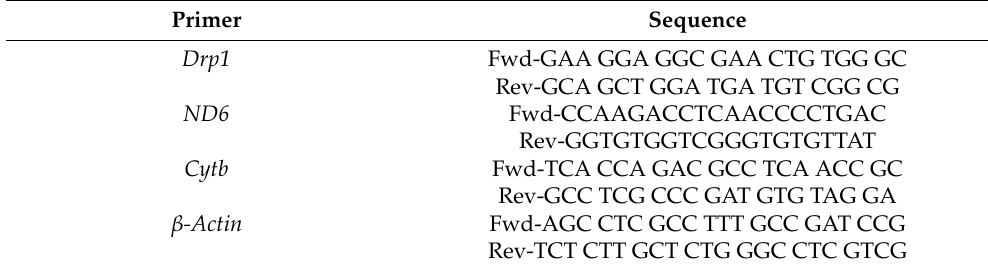
Table 1. Primer sequences for human